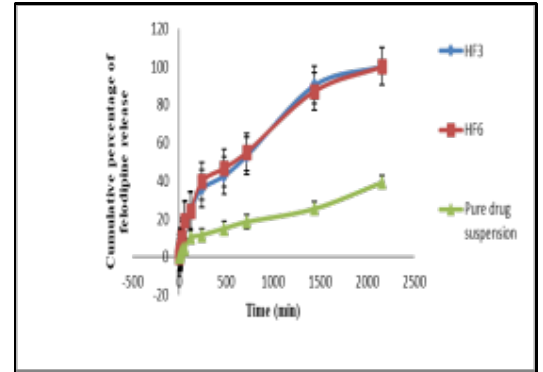
Figure 3. In vitro felodipine release profile from LPHNs formulations HF3,HF6 and the pure drug at HCl buffer pH 1.2 + 0.3 % polysorbate 80 solutions, the values of mean ±SD (n=3).